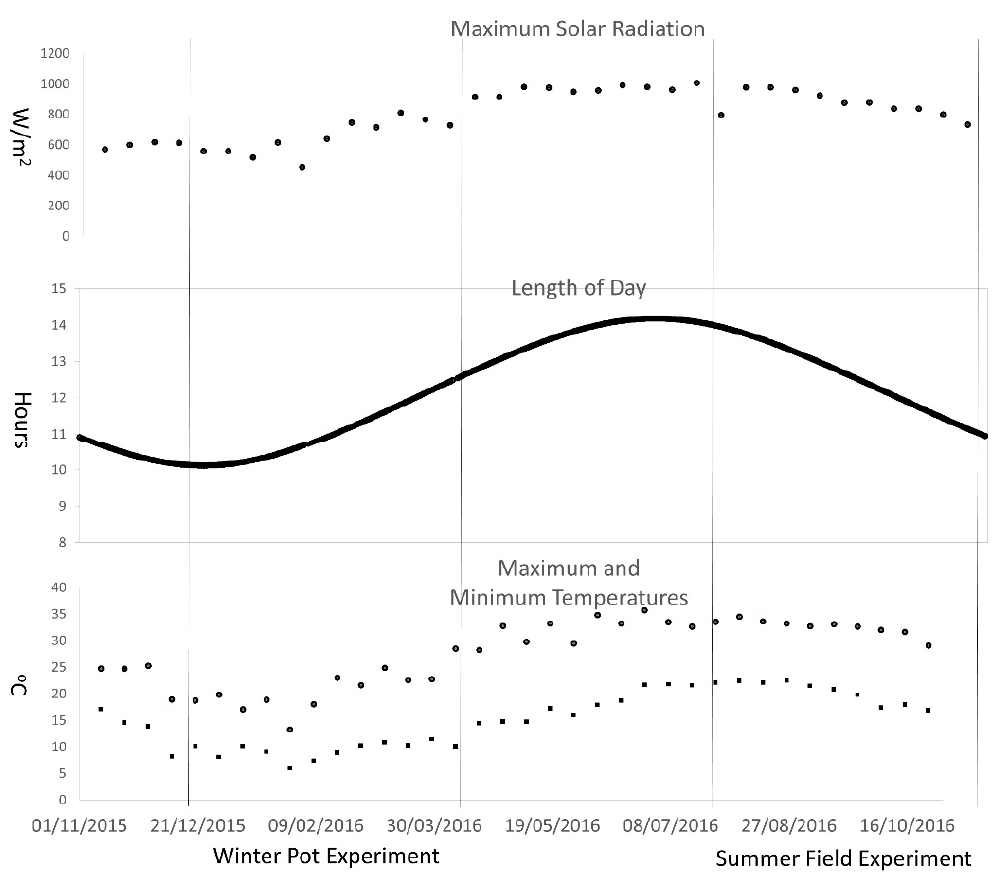
Figure 1. Solar radiation ( top ), hours of daylight ( middle ), and maximum and minimum temperatures ( bottom ) measured at the Gilat Research station during the year when the two experiments took place. The time frame of each experiment is blocked off at the bottom of the figure.